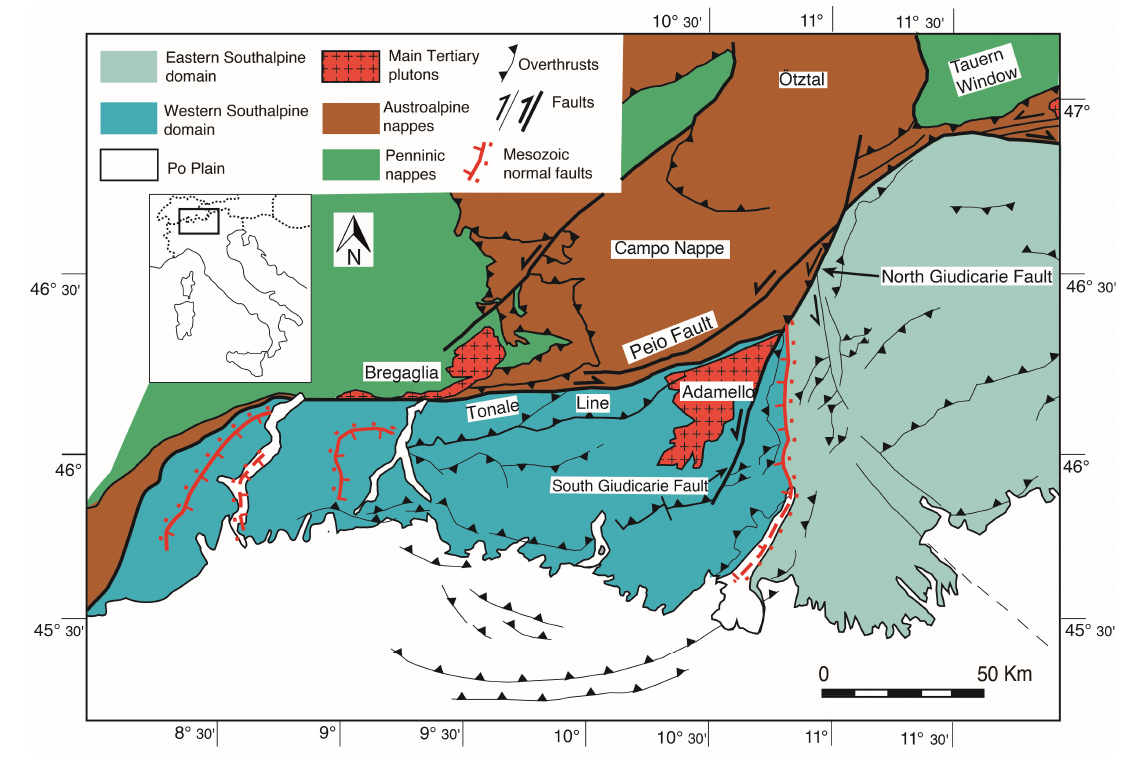
Figure 1. Tectonic map of the Central Alps with main Tertiary plutons.